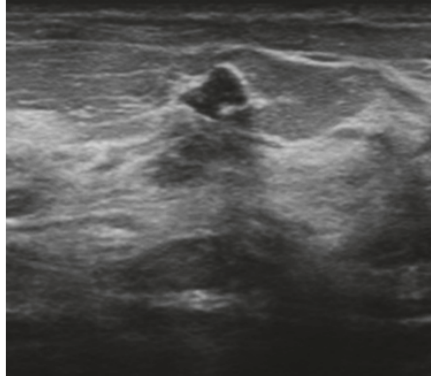
Figure 6: 33-year-old high risk woman (prior history of irradiation to the chest). Screening MRI shows a focal nonmass enhancement in the right breast. Biopsy shows stromal fibrosis. Initial follow-up MRIafter6monthsshowsstableappearance.FurtherscreeningMRI scans show slight regression in